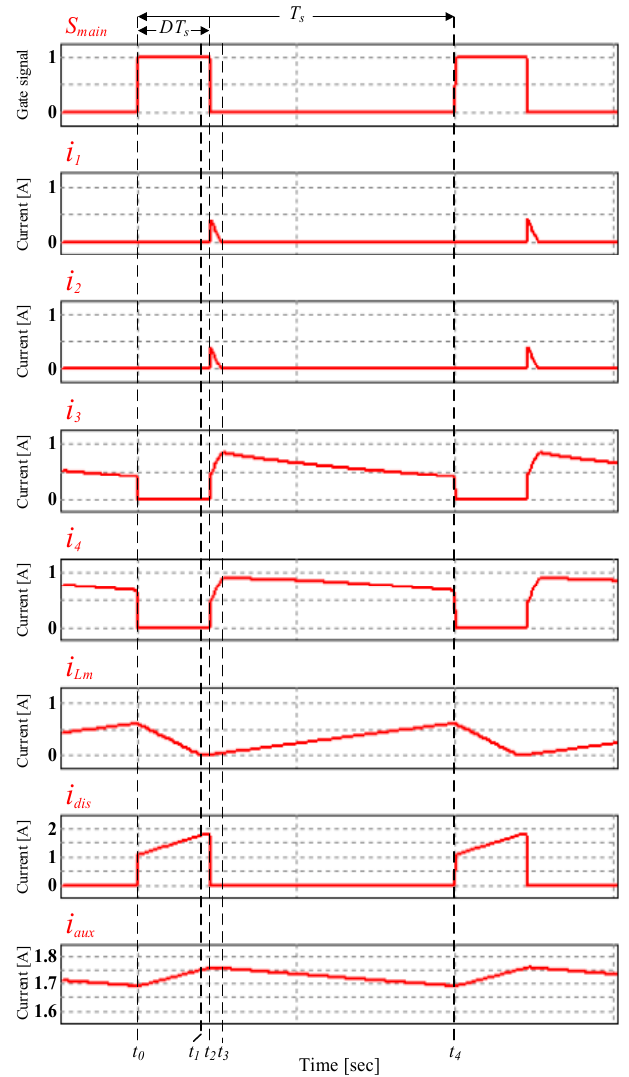
Figure 11. Simulated operating waveforms of the proposed circuit .